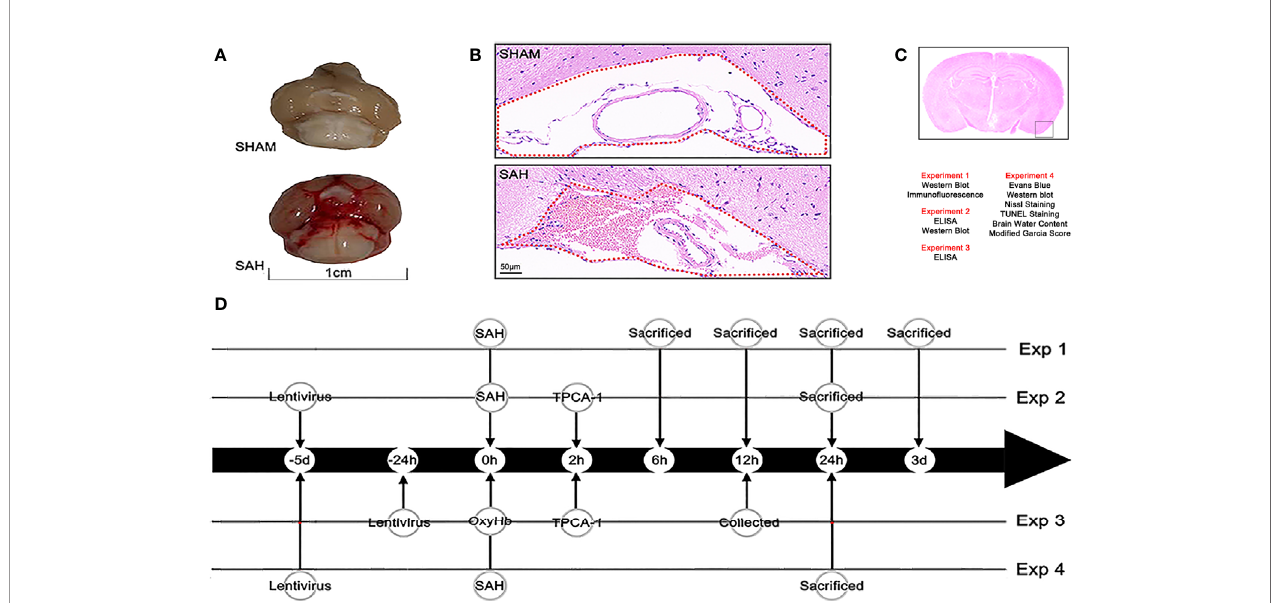
FIGURE 1 | Mouse model of SAH and experimental design. (A) A view of the skull base brain tissue in the sham and SAH groups. Blood was deposited on the skull base in the SAH group. (B) Subarachnoid space of the skull base in the sham group and SAH group (hematoxylin and eosin [H&E] staining). Erythrocytes accumulated in the subarachnoid space (as shown with the red dotted line in the diagram) after injection of blood into a prechiasmatic cistern. (C) Observation region and the four parts of the experiment and the methods used in each part. (D) Flow chart of the experimental design showing the operations at different time